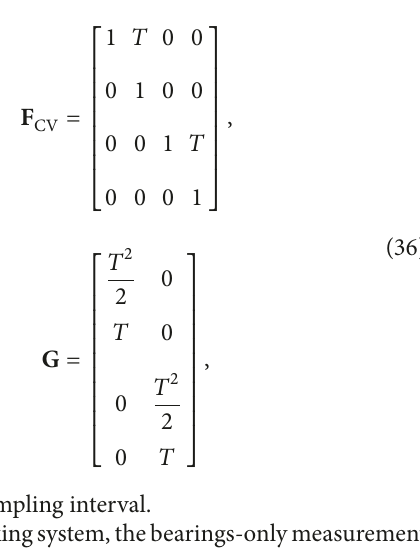
respectively, and the partial magnification is given to show the details of the curve. It can be seen that the tracking accuracy of CKF is significantly lower than that of other filters, and the proposed SSRCQKF-2 and SSRCQKF-3 have achieved higher target tracking accuracy than that of SSRCKF. The average RMSE of the various filters is shown in Table 3, and compared with CKF, the estimated position accuracy of SSRCKF is improved by 20.85%, indicating that the spherical simplex- radial cubature rule has higher accuracy than spherical-radial cubature rule in this simulation. Since the second-order Gauss-Laguerre rule is used in the SSRCQKF-2, the accuracy is improved by 1.86% compared to SSRCKF. Due to the more quadrature points used in SSRCQKF-3, its accuracy is higher than that of SSRCQKF-2 by 1.50%. Through the analysis